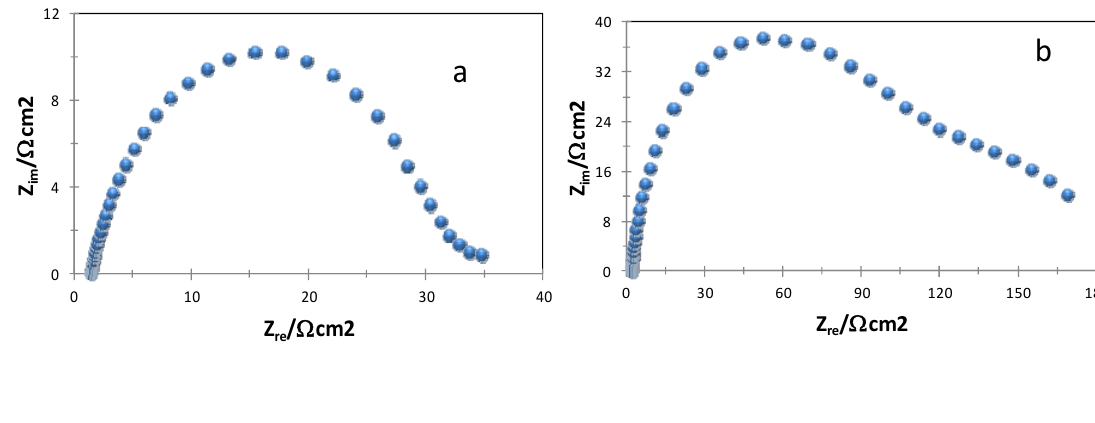
Figure 1. Experimental impedance data, Nyquist plots, recorded in the systems a) API